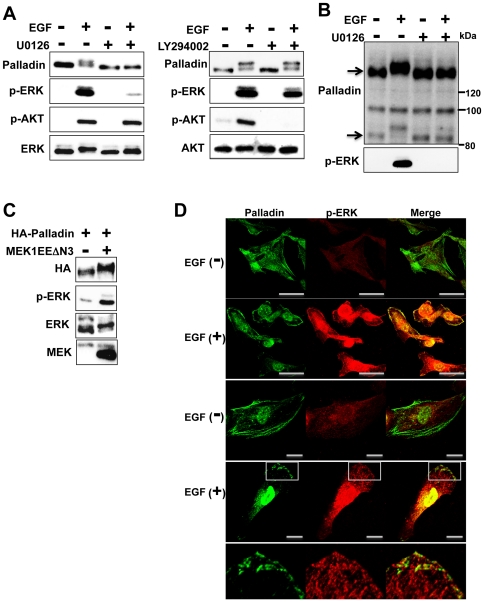
Palladin phosphorylation is dependent on the MEK/ERK pathway.(A) Serum-starved Vero cells were treated with EGF in the presence or absence of the indicated inhibitors. Five minutes after stimulation, cells were lysed and immunoblotted with anti-palladin antibody. (B) HeLa cells were treated as in (A) and immunblotted with anti-palladin antibody. Arrows indicate 90 kDa and 140 kDa form of palladin. (C) Cos7 cells were transfected with HA-palladin together with or without active MEK (MEK1/EEΔN3). Twenty-four hours later, cells were lysed and immunoblotted with the indicated antibodies. (D) MDA-MB-231 cells were cultured on glass coverslips and stimulated with EGF for 5 min and then fixed to immunostain for palladin (green) and phospho-ERK (red). Pictures were taken using an A1Rsi confocal microscopy (Nikon). Images in the bottom panel are partially enlarged images of the squared fields of the pictures. (Upper panels; scale bar = 50 µm, Lower panels; scale bar = 15 µm).